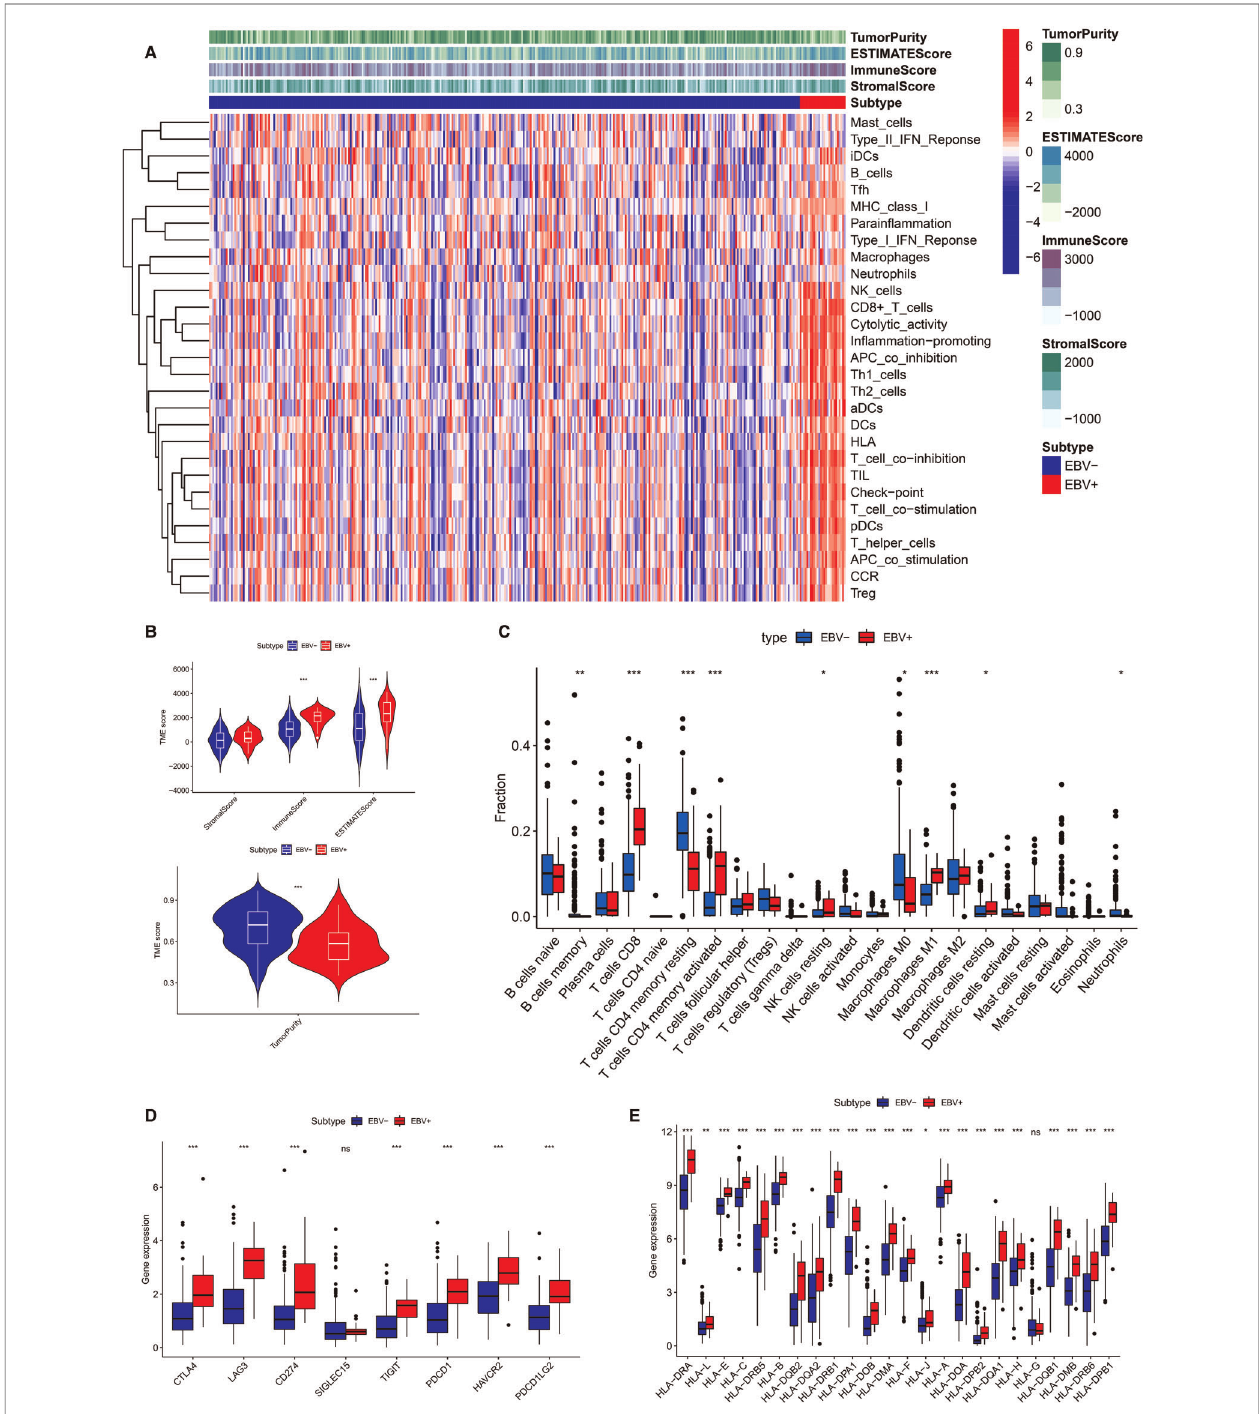
FIGURE 4 | Differences of TME characteristics between EBVaGC and EBVnGC. ( A ) ssGSEA analysis of EBVaGC (red) and EBVnGC (blue) samples according to 29 immune-associated gene sets. ESTIMATE was used to evaluate stromal score, immune score, ESTIMATE score, and tumor purity. ( B ) Differences of stromal score ( p >0.05), immune score ( p <0.05), ESTIMATE score ( p <0.05), tumor purity ( p <0.05). ( C ) Differences in the proportion of immune cell in fi ltration analyzed by CIBERSORT. ( D,E ) The expression of ICPs and HLA genes expression levels between EBVaGC and EBVnGC. CD274 (PD-L1), PDCD1(PD-1), PDCD1LG2